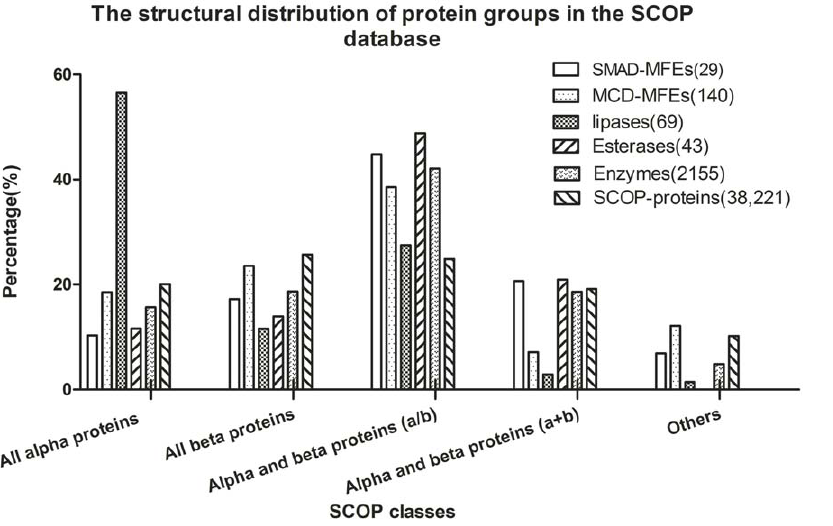
Figure 3. The structural distribution of protein groups in the SCOP database. It is noted that about 38.57% of MCD-MFEs, 44.83% of SMAD- MFEs, 48.84% of esterases and 42.09% of enzymes belong to alpha and beta proteins (a/b); comparatively, only 24.85% of SCOP proteins belong to a/